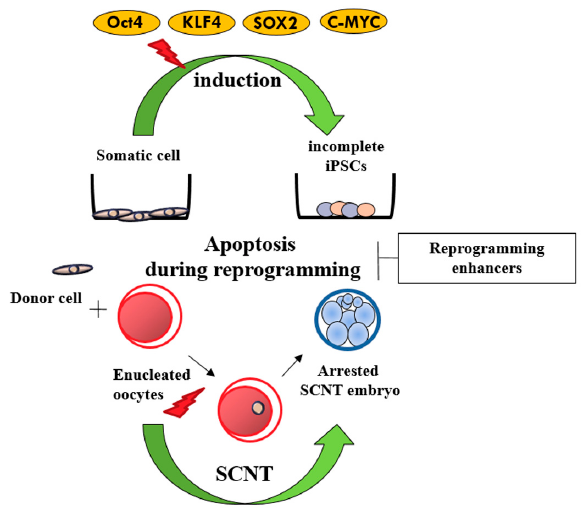
Figure 3. Apoptosis during reprogramming. iPSCs: induced pluripotent stem cells, SCTN: somatic cell nuclear transfer.